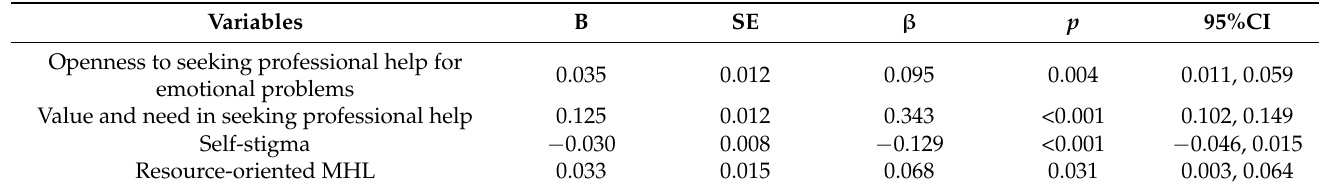
Table 4. Multivariable analysis of factors associated with the help-seeking intention for depression ( n =